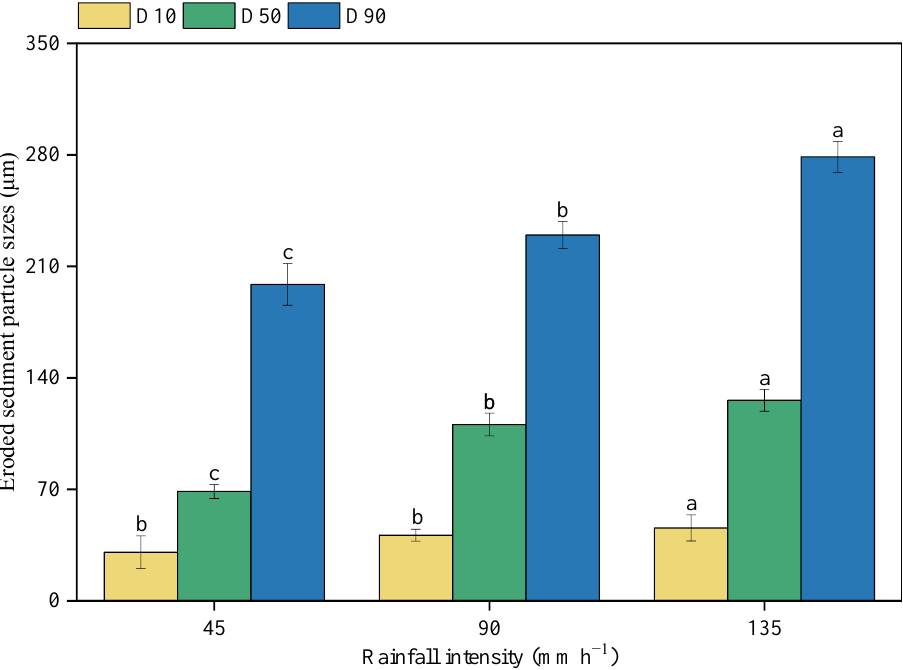
Figure 7. The size distributions of the eroded sediments under different rainfall intensities. Note: D10, D50, and D90 were the corresponding particle sizes when the cumulative particle size distribution of the sediment samples reached 10%, 50%, and 90%. The different letters indicate significant differences among different rainfall intensities ( p < 0.05).